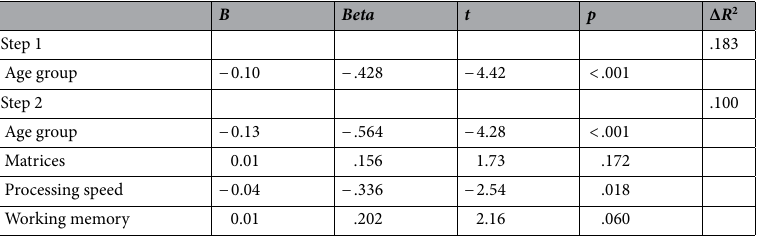
Table 7. Regression predicting social understanding composite. Δ R 2 represents the additional variance counted for by all the variables in a step. Regression statistics given with relevant variables at a step in the prediction equation. Age group was treated as a dichotomous variable (young vs. older adults) in the